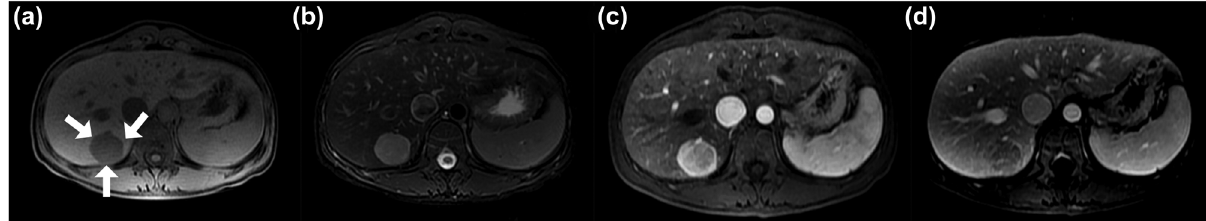
Figure 3: Transverse abdominal MRI using di ff erent contrasts, including T1 - weighted of a primary hepatic perivascular epithelioid cell tumor ( a ) , T2 - weighted ( b ) , and dynamic contrast - enhanced magnetic resonance imaging ( c and d ) . The tumor showed low signal intensity on T1 - weighted imaging and high signal intensity on T2 - weighted imaging ( arrows ) . Hyper - intensity was seen in the arterial phase ( 25 – 30 s ) , while hypo - intensity was seen in the portal phase ( 60 s ) .